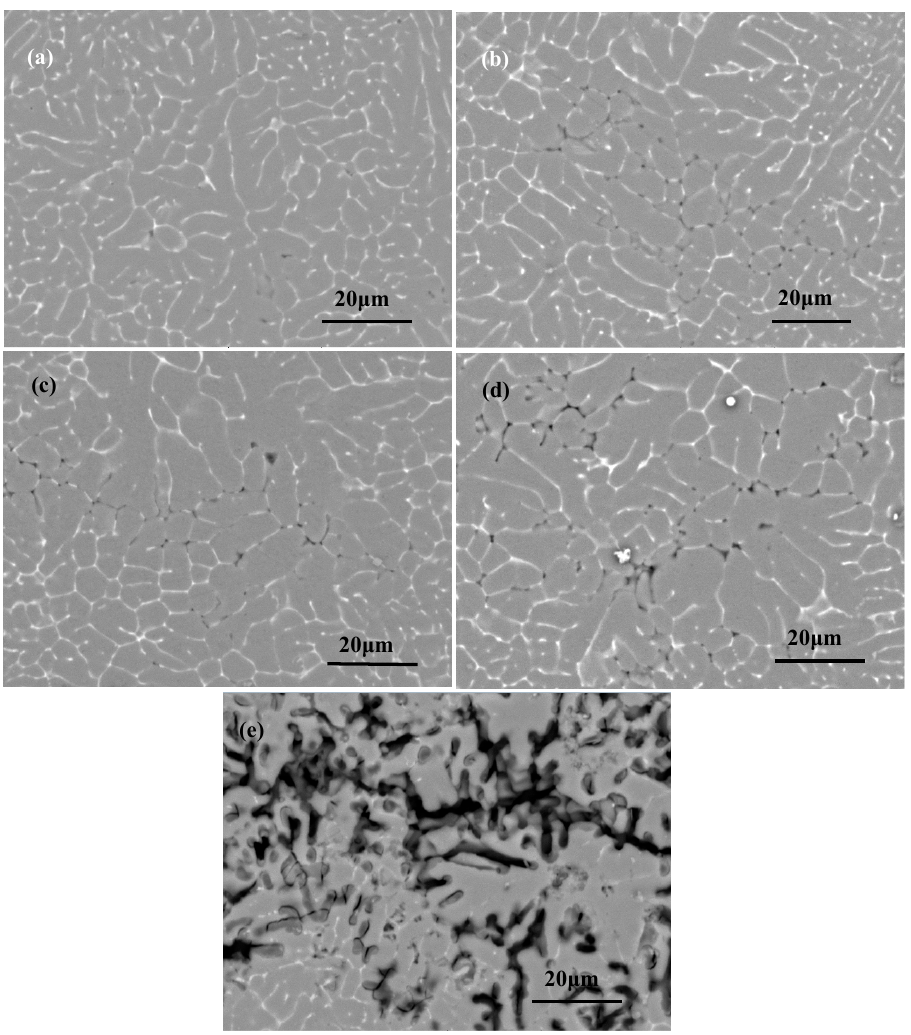
Figure 5. Surface morphologies of the 2060 Al–Li alloy laser welding joint after immersion corrosion in 3.5% NaCl solution. ( a ) 6 h; ( b ) 12 h; ( c ) 24 h; ( d ) 48 h; ( e ) 72